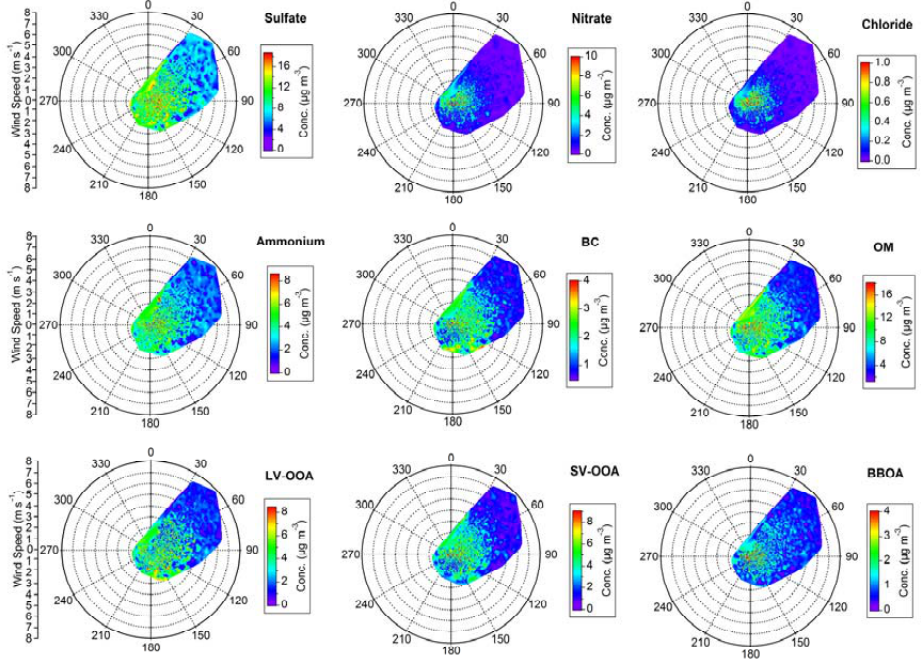
Fig. 7. The variation of PM 1 component concentration with wind direction and speed.